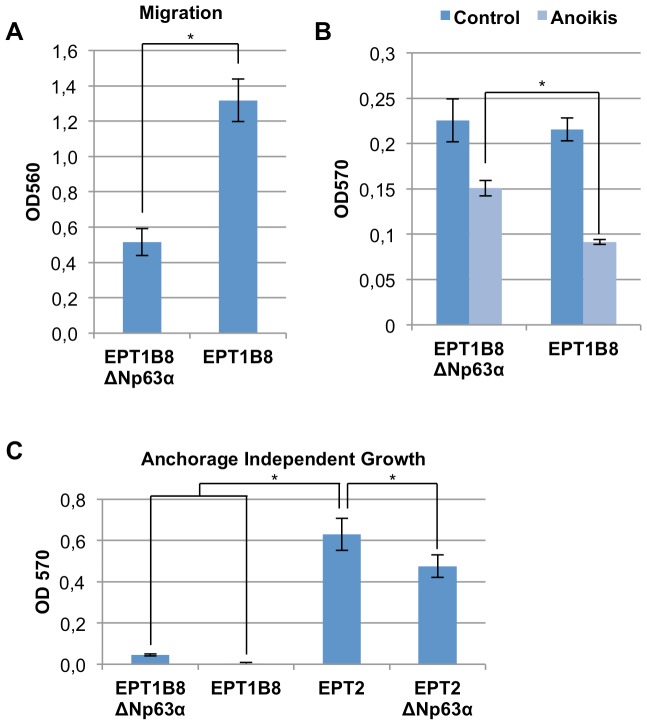
Functional changes after ΔNp63α over-expression in EPT1B8 cells.(A) Boyden chamber migration assay of EPT1B8 ΔNp63α and EPT1B8 cells. (B) EPT1B8 ΔNp63α and EPT1B8 cells grown on hydrogel covered wells (anoikis) and regular wells, cells alive stained after 24 hours. (C) Anchorage independent growth in soft-agar for EPT1B8 ΔNp63α, EPT1B8, EPT2 and EPT2 ΔNp63α. Error bars show ±s.d of at least three replicates. Student’s t-test was used for statistical analysis (*, p<0.001).